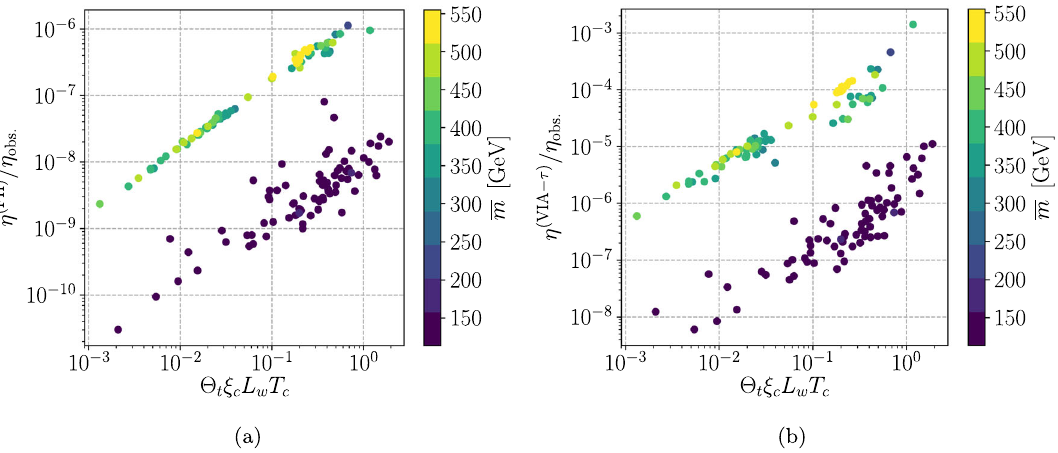
Fig. 6 Normalised BAU in the FH approach (left) and the VIA − τ approach (right) as a function of the tuning parameter combination (θ t ξ c L W T c ) for the allowed parameter points. The colour code indicates the average mass scale m